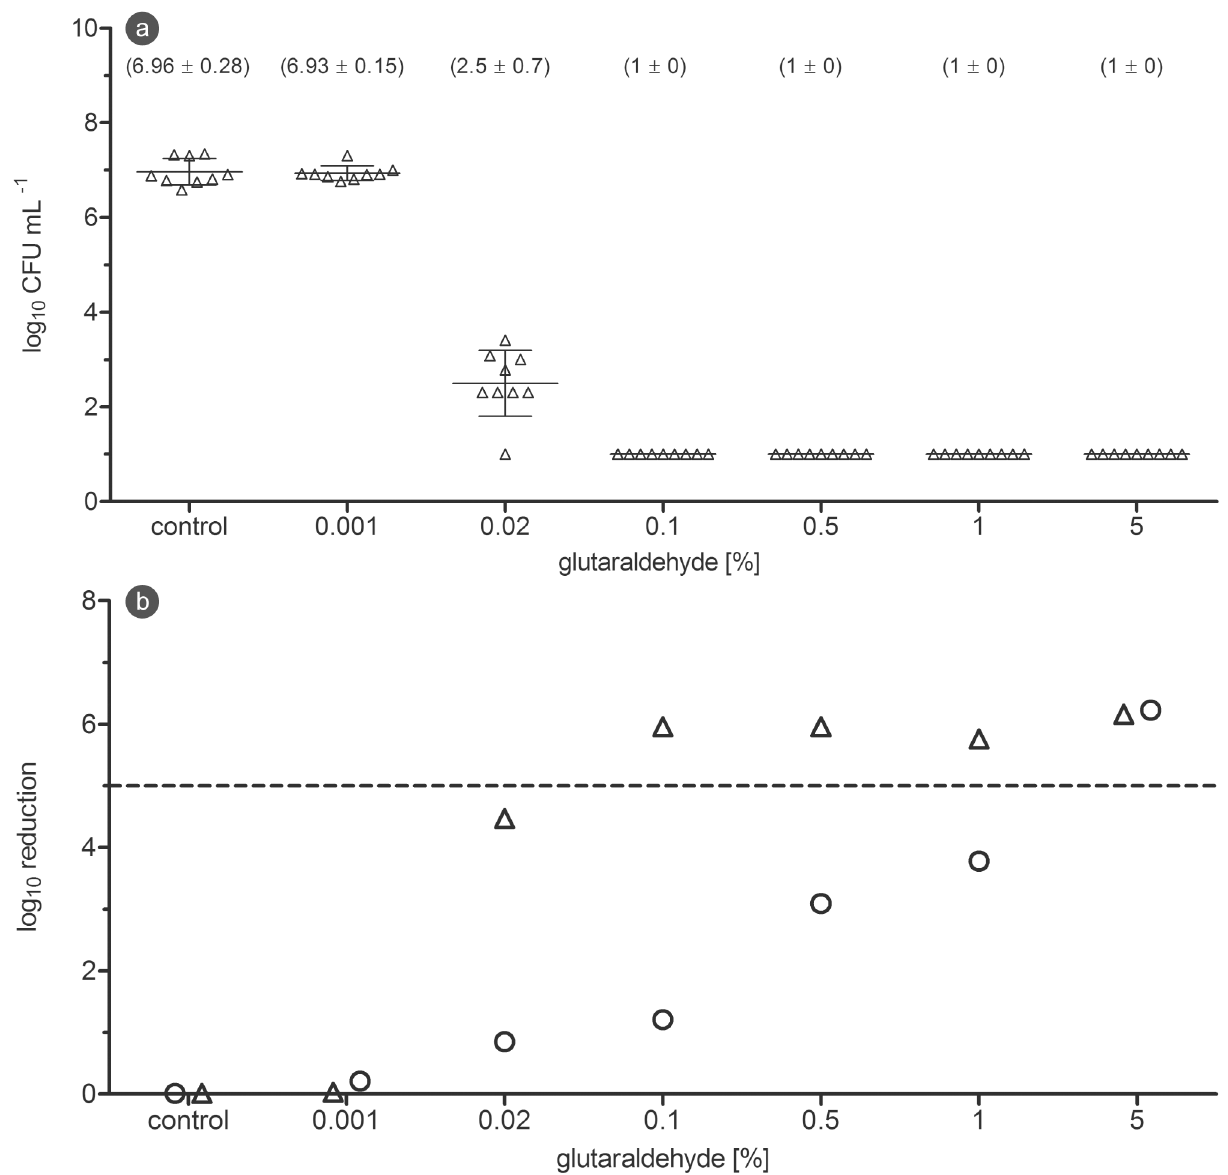
Fig 5. Reduction of planktonic bacteria and biofilm in comparison. (a) CFU counts after 30 min glutaraldehyde treatment of planktonic bacteria of P . aeruginosa . (b) Reduction after 30 min glutaraldehyde treatment of P . aeruginosa biofilm and planktonic bacteria ( O : biofilm (mean of three independent experiments); Δ : planktonic (mean of three independent experiments); dashed line: 5log 10 reduction goal).